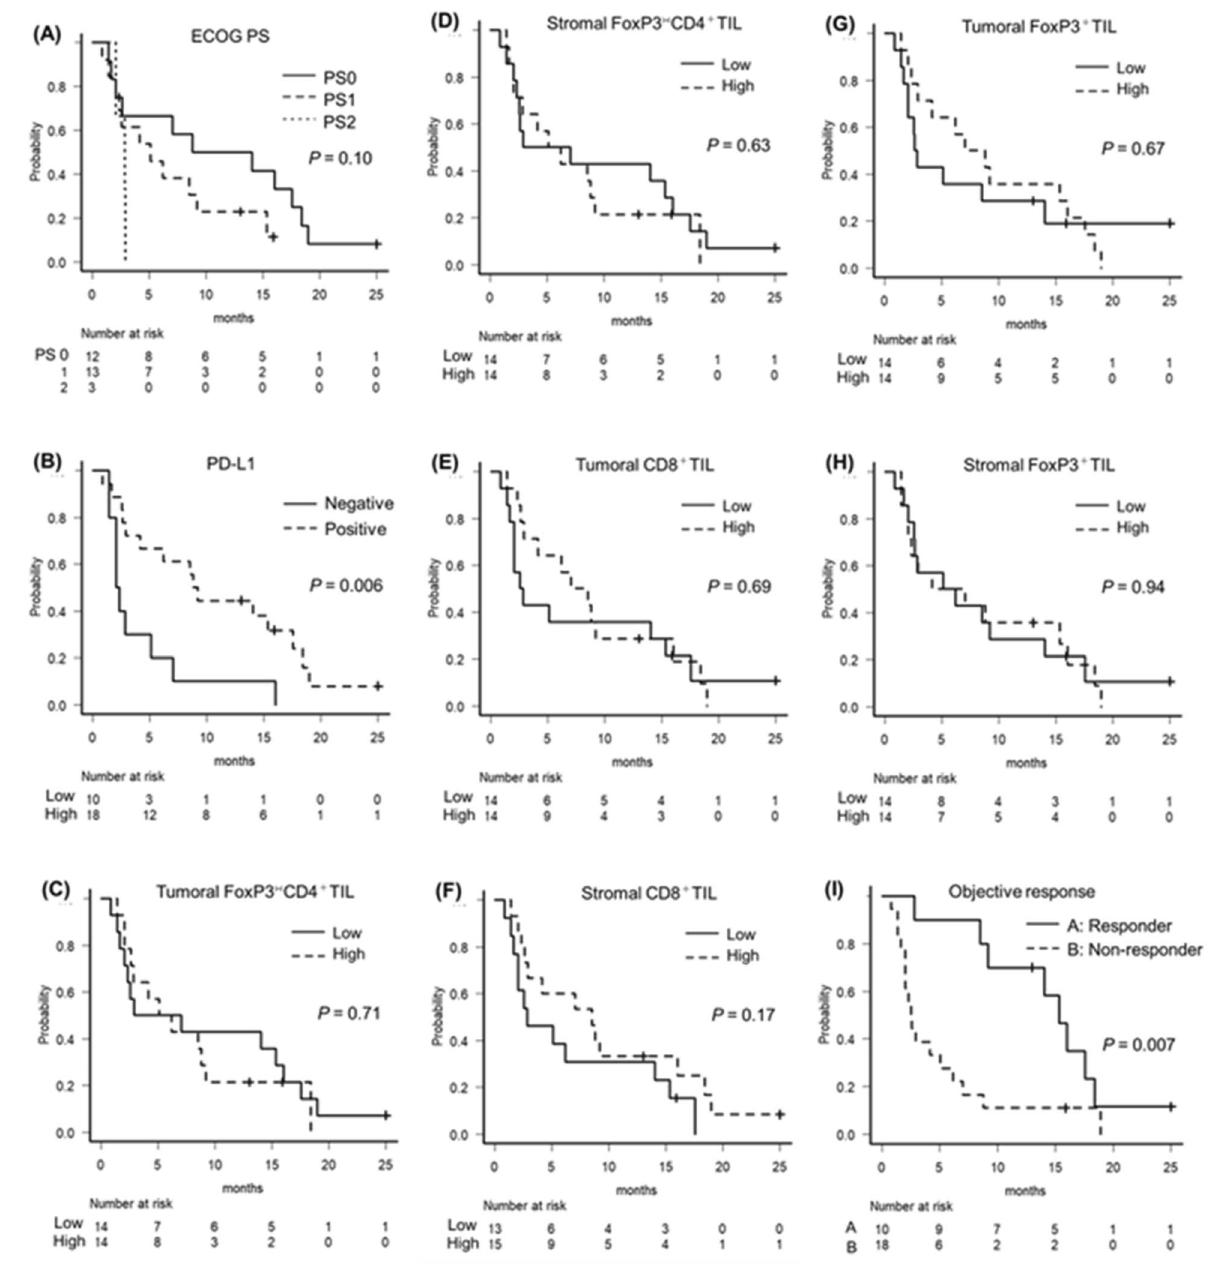
Figure 2. Kaplan–Meier curves for PFS of each type. ( A ) Survival curve of ECOG PS. ( B ) PD-L1. ( C ) tumoral FoxP3 − CD4 + TIL. ( D ) stromal FoxP3 − CD4 + TIL. ( E ) tumoral CD8 + TIL. ( F ) stromal CD8 + TIL. ( G ) tumoral FoxP3 + TIL. ( H ) stromal FoxP3 + TIL. ( I ) Objective does not negate the findings of previous meta-analyses because we limit the observation period to after the start of nivolumab treatment. On the other hand, Hanna et al. evaluated TILs in 42 actual ICI-treated virus-negative HNSCC patients with fresh specimens collected before ICI administration and reported that CD8 + TIL levels were higher in responders compared to non-responders 13 . However, no other reports have evaluated TILs in head and neck cancer patients treated with ICI, and no meta-analysis exists. Future validation in a large cohort using fresh specimens before ICI treatment is needed. FoxP3 is a marker of immunosuppressive regulatory T cells (Treg) 14 . Therefore, immune response to ICIs is predicted to be poor in the presence of FoxP3 positive cells. However, the significance of FoxP3 + TIL in HNSCC patients is not clear. In a meta-analysis of 15,512 cancer patients in 76 studies, high FoxP3 + Treg infiltration was associated with shorter OS in many solid tumors but with improved OS in colorectal, esophageal, and HNSCC 15 . Similarly, Seminerio et al. reported a positive correlation between FoxP3 + TIL and OS in 205 patients with HNSCC 16 . However, these studies have several issues, including short observation periods and not evaluating